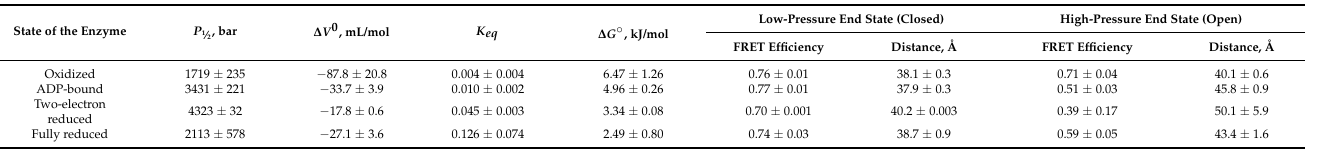
Table 2. Parameters of the pressure-induced transition in SbCPR-2DY monitored by changes in FRET efficiency